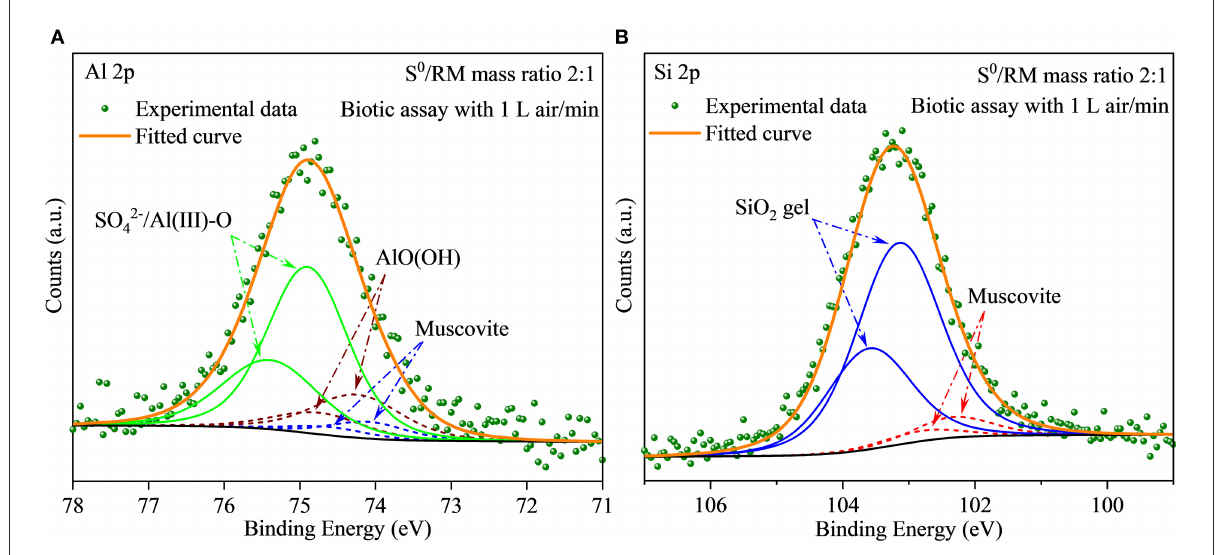
FIGURE12 (A,B) XPS spectra of Al and Si in the solid residues after bioleaching of metals from RM. The bioleaching was conducted for 27 days in a 5-L reactor with the S 0 /RM mass ratio of